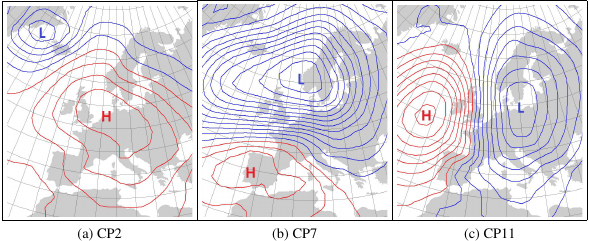
Fig.3. 1hPaisobarsofthemeansealevelpressureanomaliesofCPsrelatedtohighprecipitationinten- sities Fig. 3. 1hPa isobars of the mean sea level pressure anomalies of CPs related to high precipitation